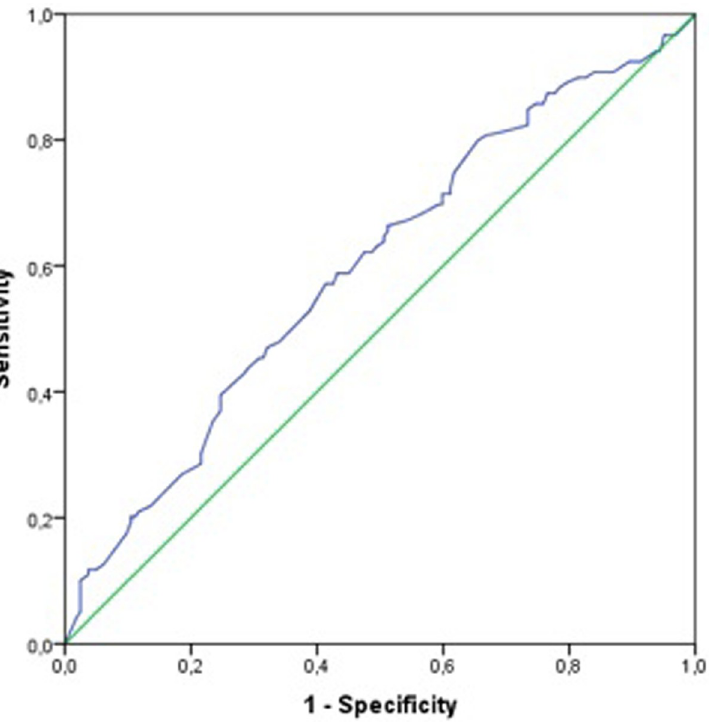
Fig 5. ROC curve for